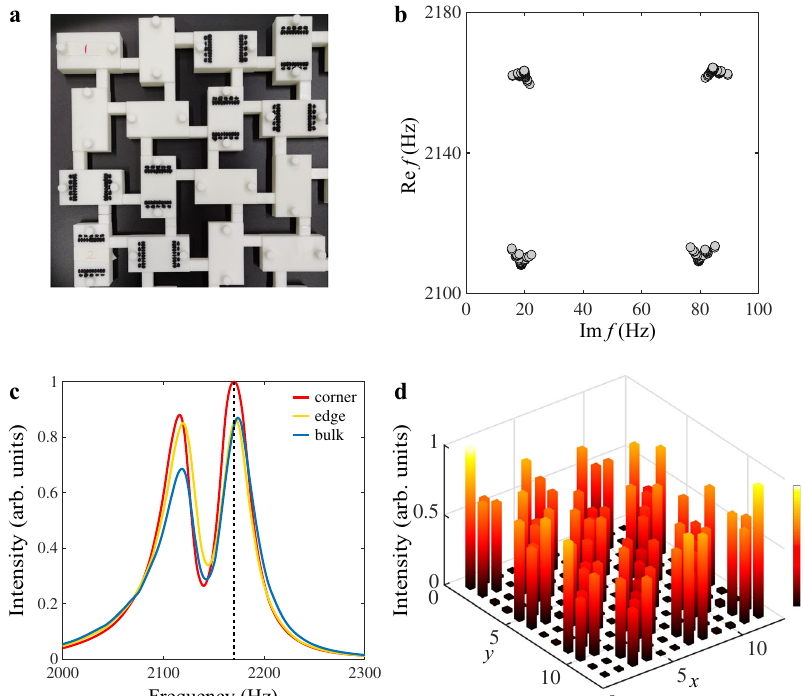
Fig. 4 Experimental observation in the trivial lattice. a Photo of one unit cell for the trivial lattice. b Simulated eigenfrequencies for the trivial sample with 12 resonators along x and y directions. c Measured spectra for the sample in ( a ). Red, yellow, and blue lines represent the spectra measured in one of resonators within the corner, edge, and bulk regions, respectively. d Measured intensity pro fi le around the spectra peak denoted by the black dashed line in ( c